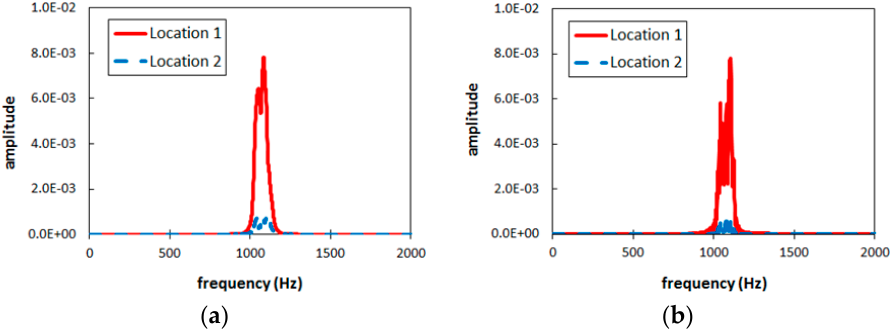
Figure 14. Amplitude variation with frequency: ( a ) accelerometer and ( b ) microphone sensor.